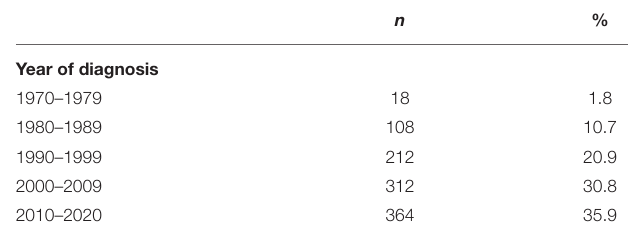
TABLE 1 | Demographic and disease characteristics of the sample ( N =